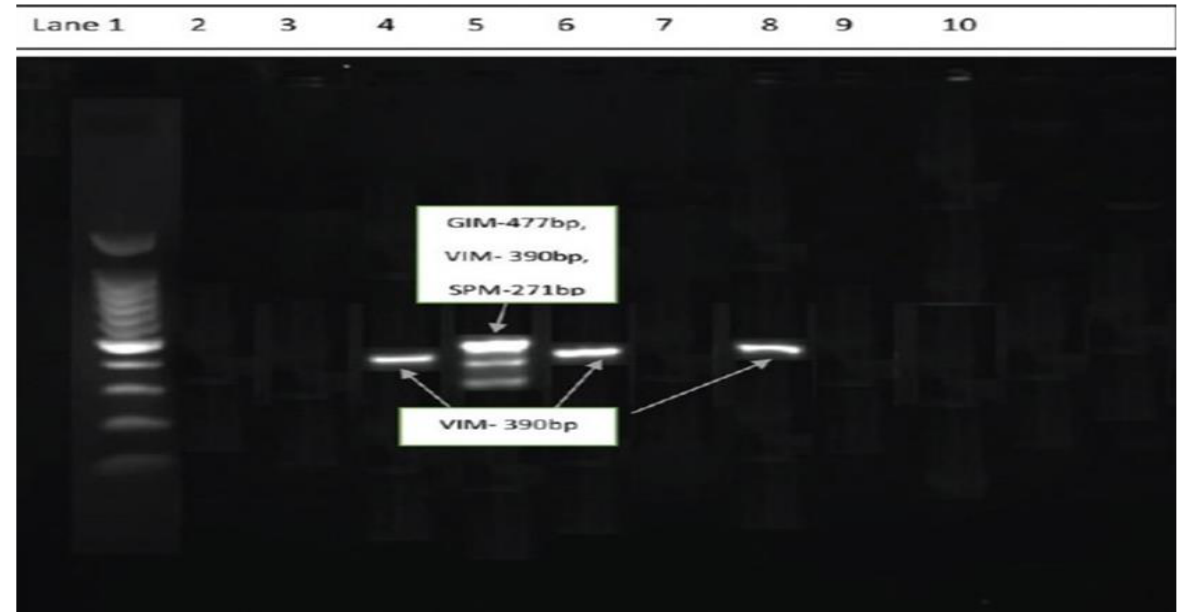
Figure 1. Multiplex chain reaction showing blaVIM , blaGIM, blaSPIM